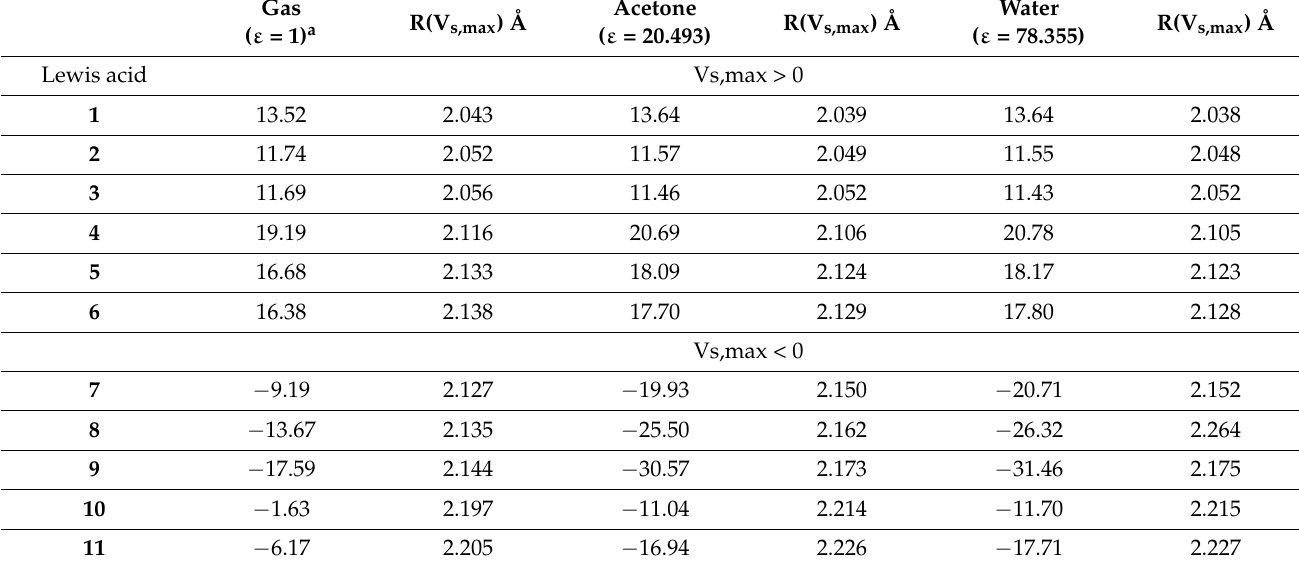
Table 1. Molecular electrostatic potential maxima (kcal/mol) on the 0.001 au isodensity surface at Ch atom of monomers (Ch = S, Se) and minima (kcal/mol) of the HCN, CH 3 CN, calculated at the MP2/aug-cc-pVDZ level of